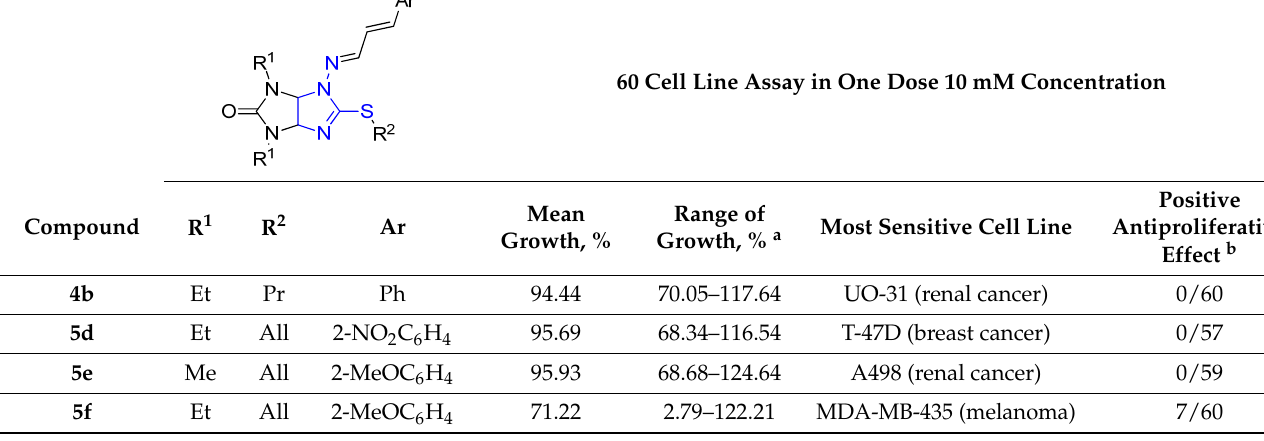
Table 3. Antiproliferative screening data at a concentration of 10 µ M.